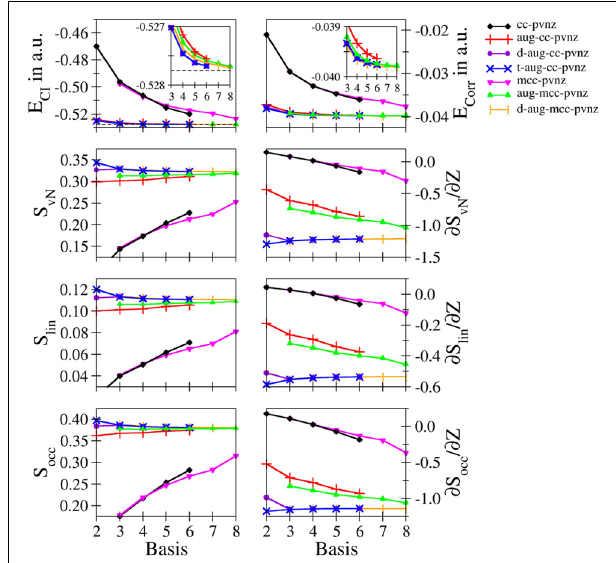
FIGURE 2 | Total and correlation energy E CI and E corr in atomic units; von Neumann S vN , linear S lin and occupation number S occ entropies and their derivative with respect to the nucleic charge Z obtained for H − at the FCI level using different basis